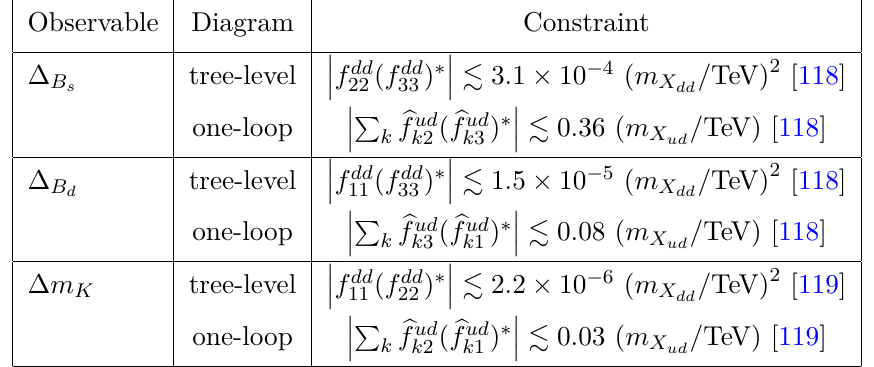
Table 5 . Latest constraints on the diquark couplings from B 0 oscillations using 95% CL experimental